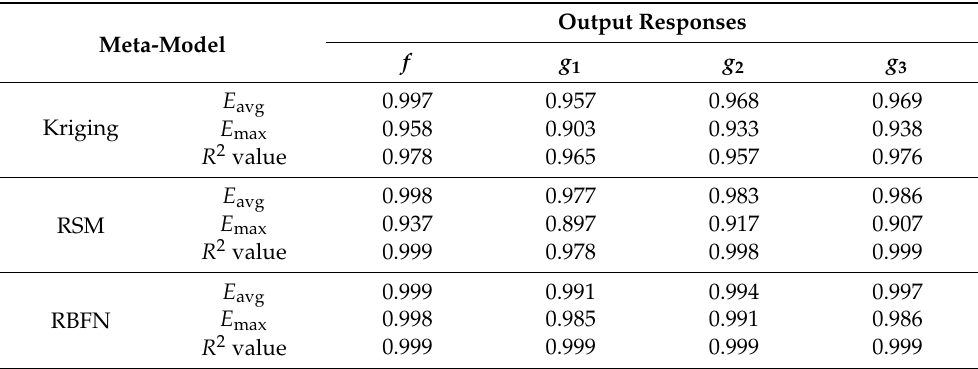
Table 5. Comparison of meta-modeling